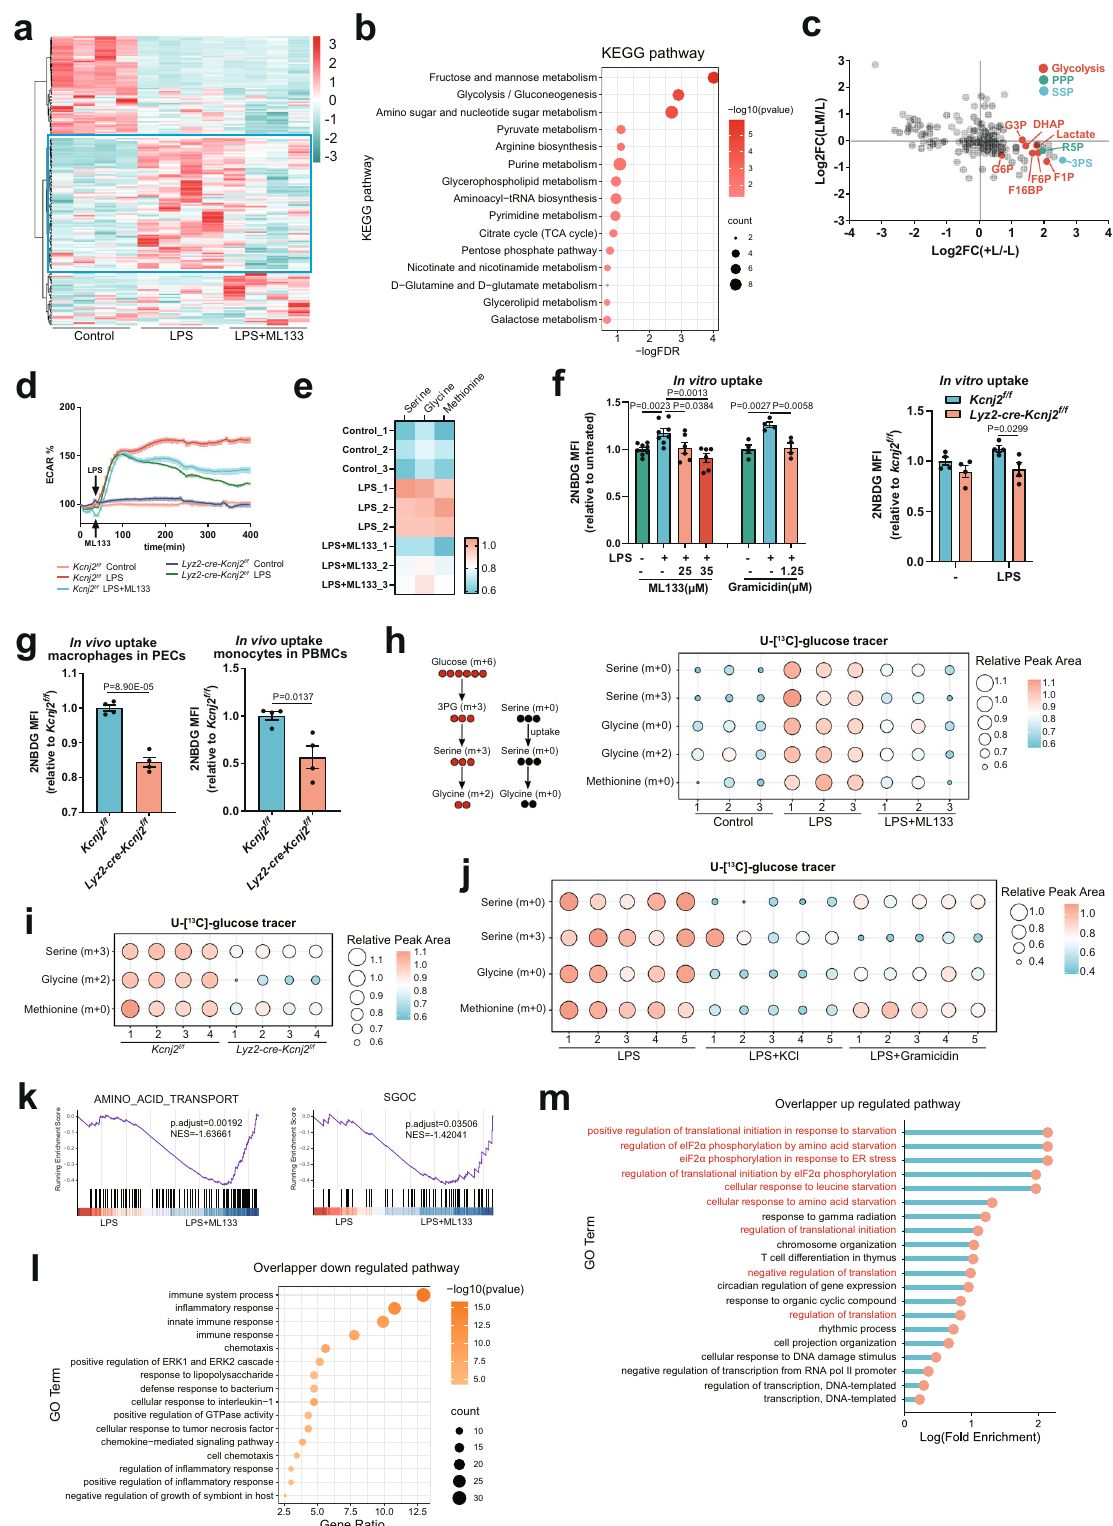
‘ in fl ammatory response ’ (Fig. 5b), and the common upregulated genes were signi fi cantly enriched in key pathways of metabolic adaptions in response to nutrient starvation such as ‘ autophagy ’ , ‘ amino acid transport ’ , and ‘ negative regulation of mTOR sig- naling ’ (Fig. 5c). The increased autophagy was con fi rmed by measuring the abundance of the autophagosome proteins LC3b-I NATURE COMMUNICATIONS| (2022) 13:3544